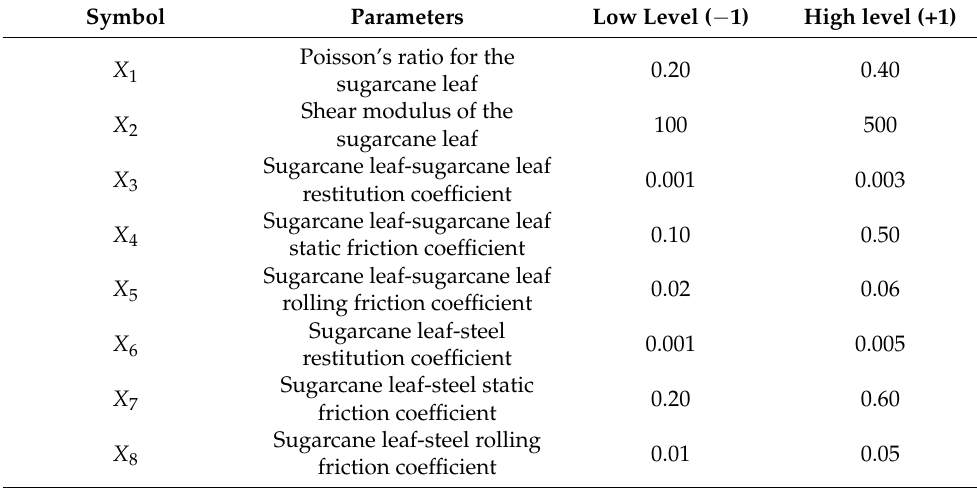
Table 2. Parameters of the Plackett-Burman